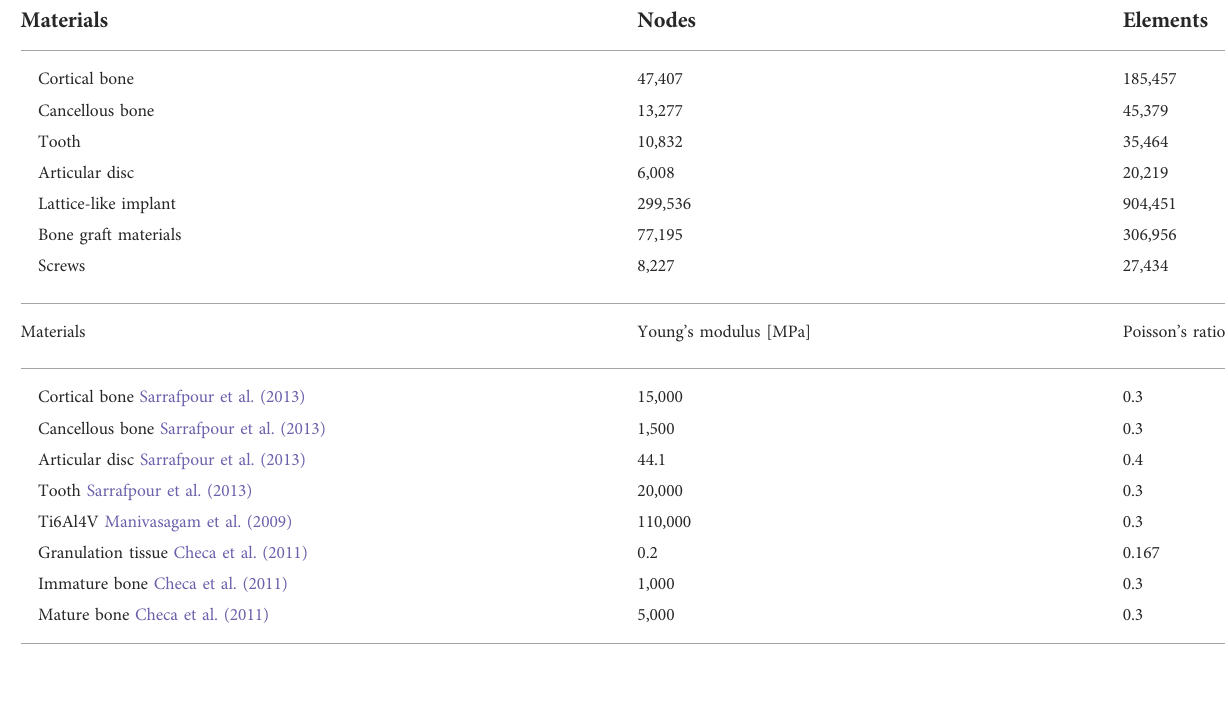
TABLE 1 Numbers of elements and nodes and mechanical properties.